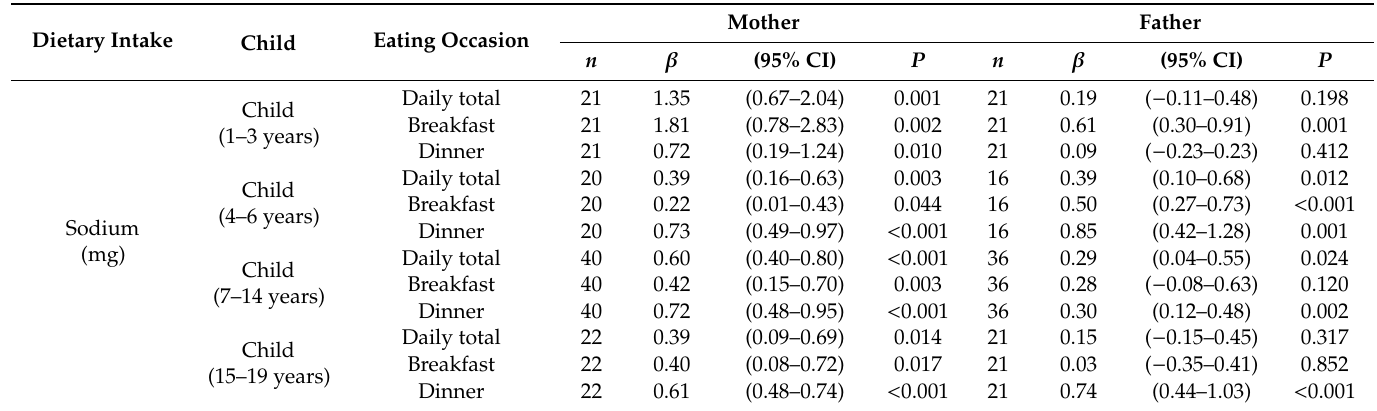
Table 2. Association between parent–child sodium and potassium